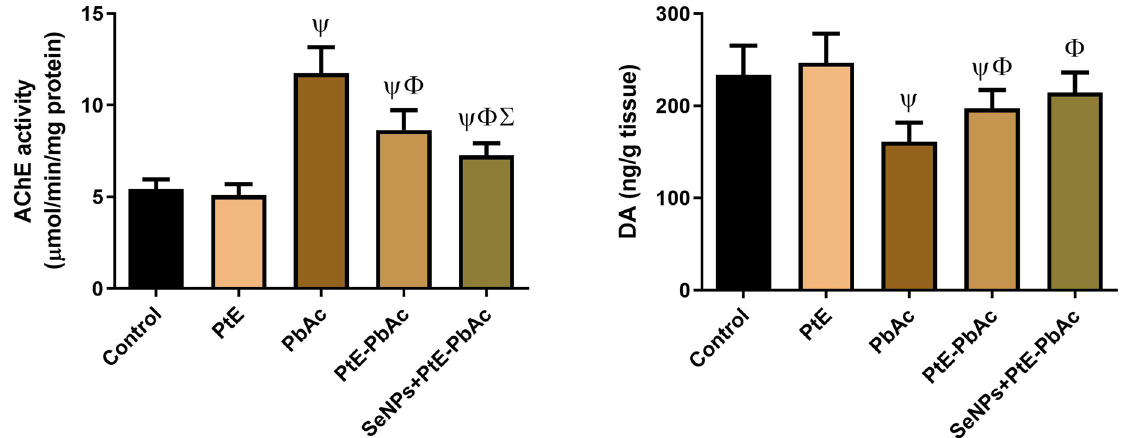
Figure 7: E ff ects of orally administered PtE or PtE - SeNPs on the levels of neural DA and AChE in the brain of PbAc - injected rats. ψ , Φ , Σ